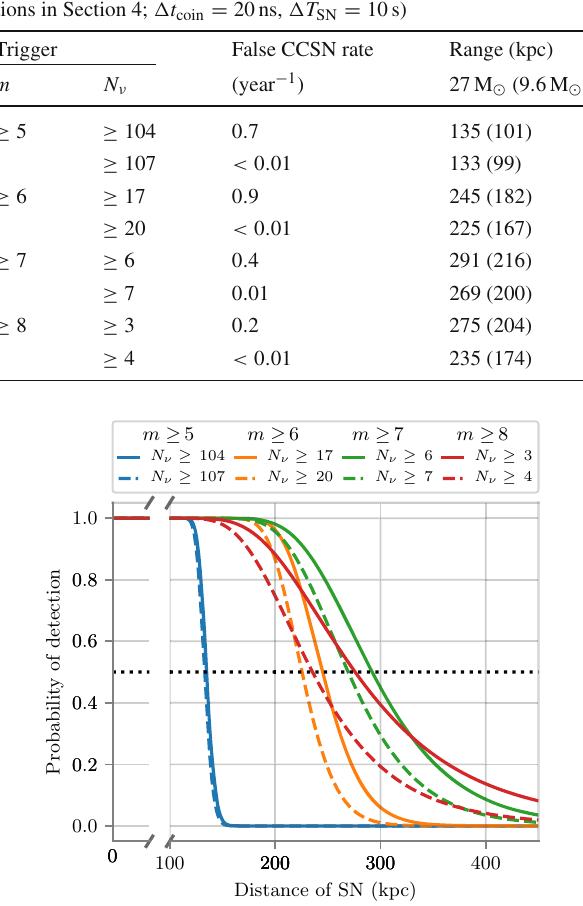
Fig. 8 Probability for the detection of a CCSN of 27M (cid:3) progenitor mass as a function of distance using the trigger conditions presented in Table 4